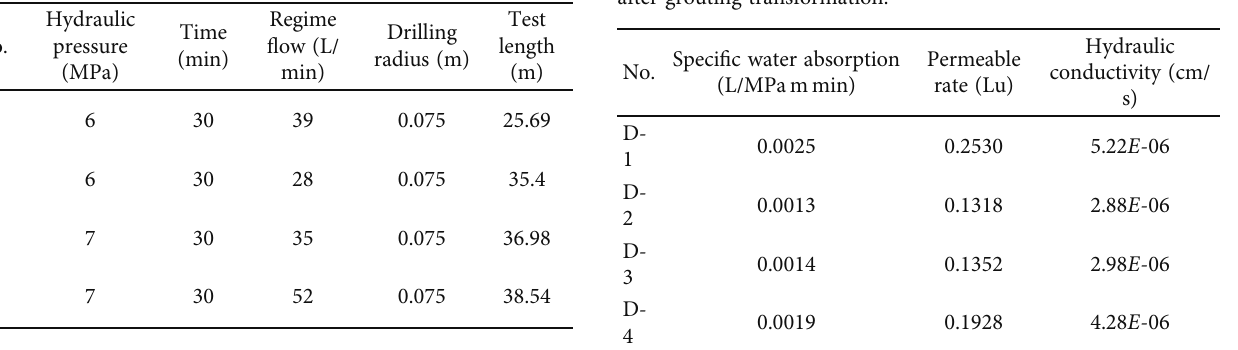
Table 3: Water pressure test data after grouting transformation of Xujiazhuang limestone aquifer.